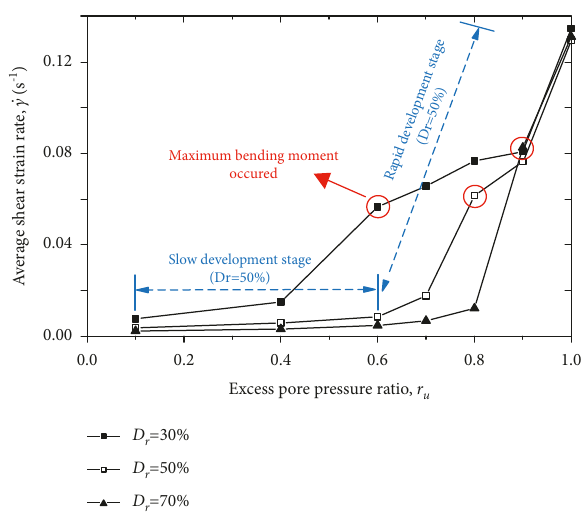
Figure 8: Variation of shear strain rate versus pore pressure ratio for different relative